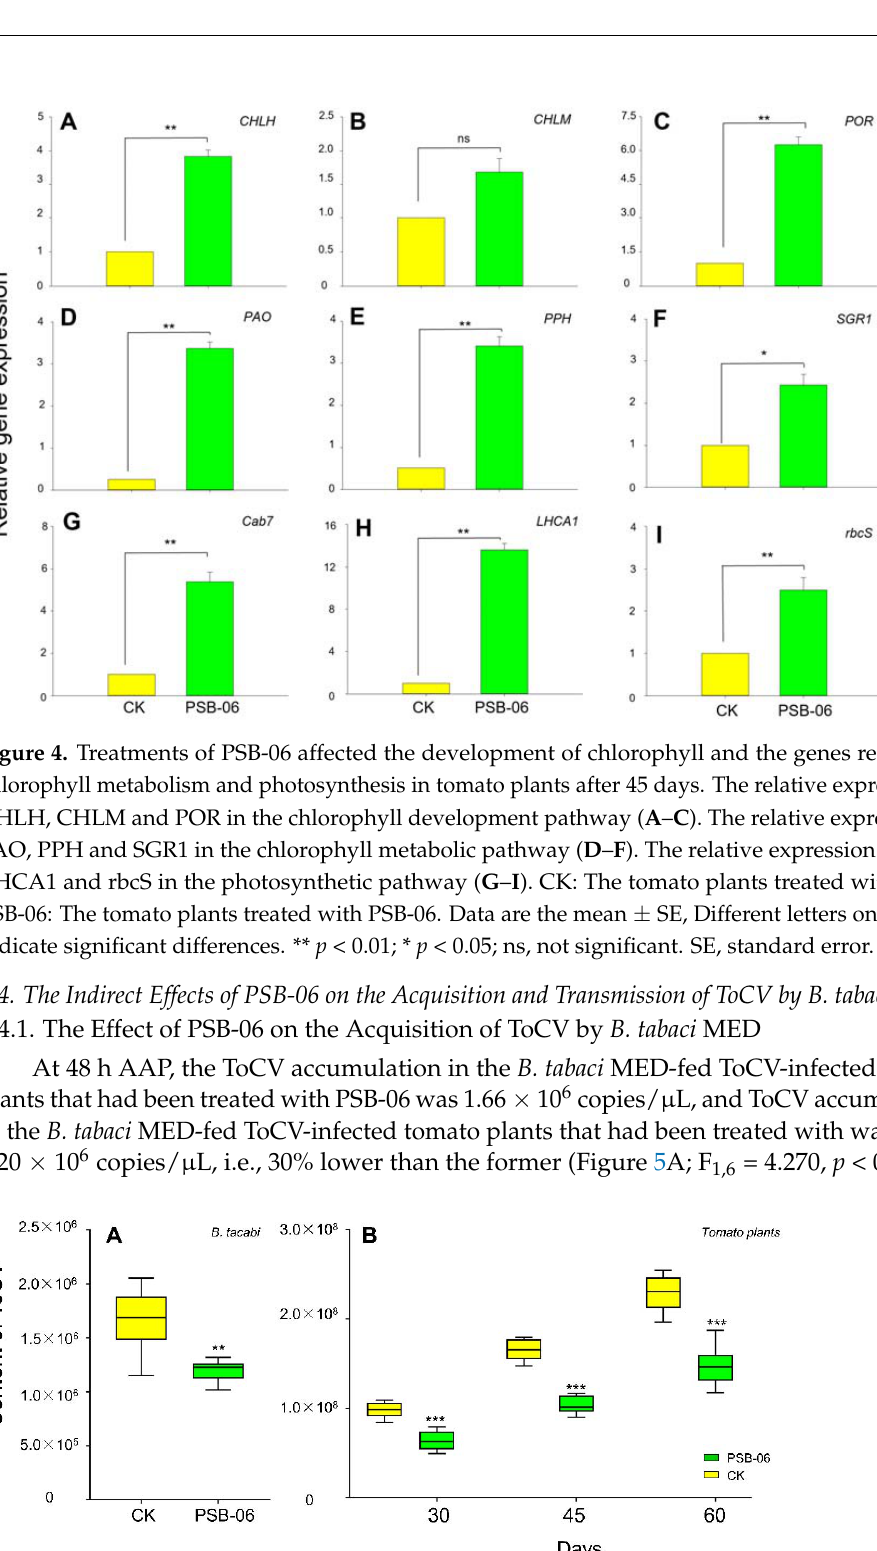
Figure 5. The effect of PSB ‐ 06 treatment on the acquisition and transmission of ToCV by B. tabaci MED. The acquisition of ToCV by B. tabaci MED at 48 AAP ( A ). The content of ToCV in the tomato plants exposed to ToCV-infected B. tabaci MED ( B ). In ( B ), X ‐ axis indicates the number (30, 45, 60) of days that the tomato plants had been infested when ToCV accumulation was determined. CK: The tomato plants treated with water. PSB ‐ 06: The tomato plants treated with PSB ‐ 06. Data are the mean ± SE, Different letters on the bars indicate significant differences. *** p < 0.001; ** p < 0.01. SE, standard error.